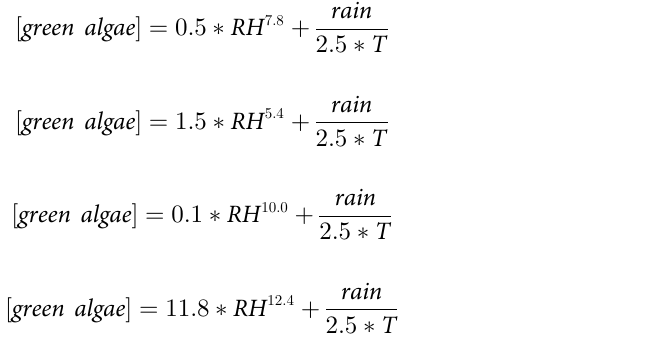
tree but exposed to sun (VA1-VA2), sheltered from tree and few exposed to sun (VA3), not sheltered and exposed to sun (VNA4-VNA5), not sheltered and close to soil (VNA6), respec- tively: